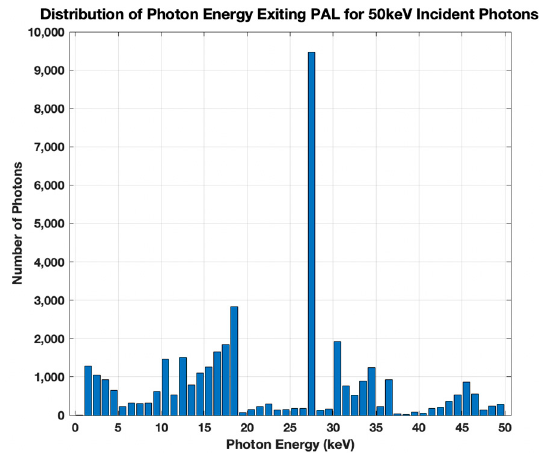
Figure 3. The energy distribution of the photons exiting the 0.5-µm thick PAL and entering the Si detector for 100,000 50-keV incident X-ray photons. The most prominent line is at Te KL 2 (27.2 keV) and Te KL 3 (27.5 keV). Te KM 2 (30.9 keV) and Te KM 3 (31.0 keV) are also visible.